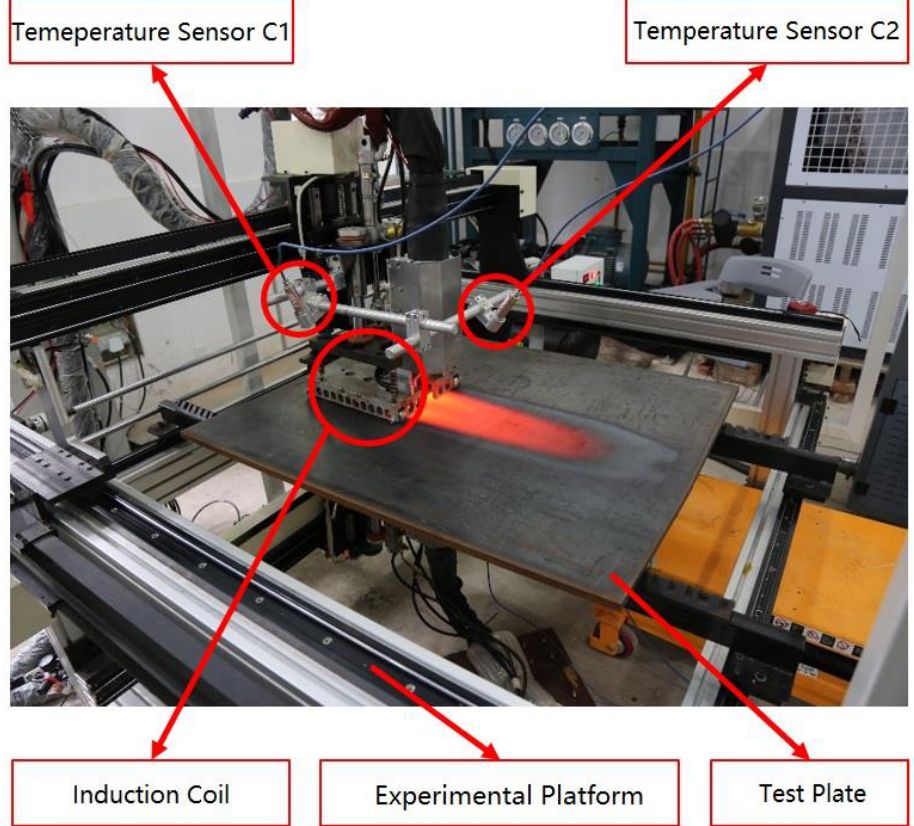
Figure 3. Plate heating test using an induction coil.